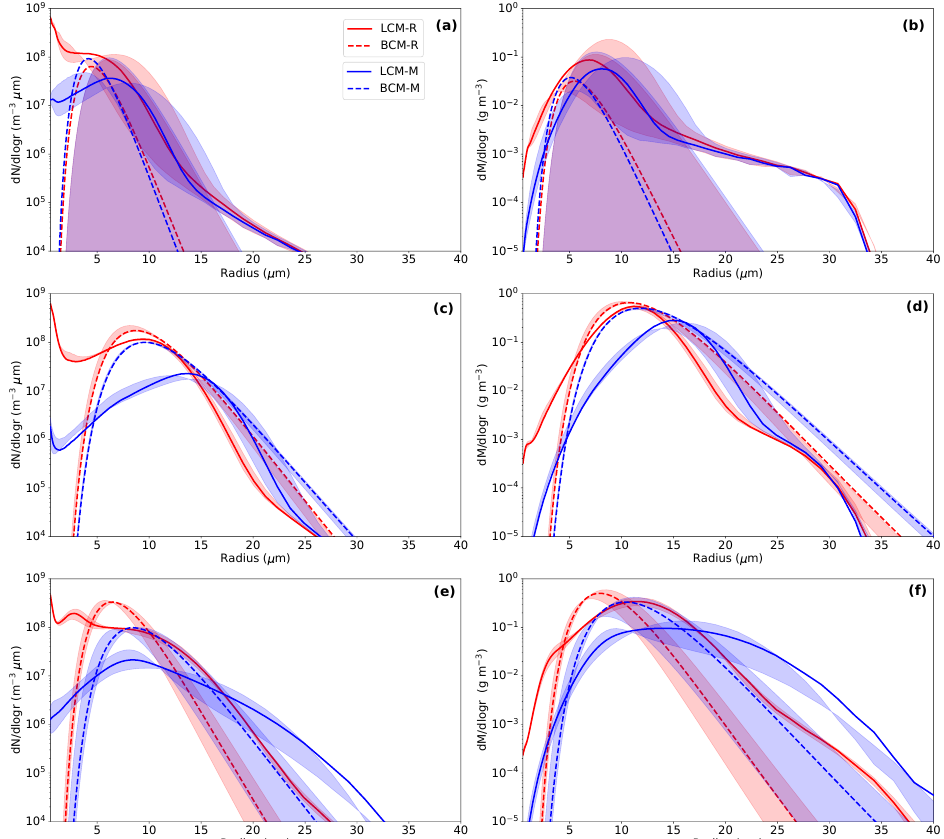
Figure 4. Instantaneous drop size distributions of number and mass density at 0300UTC ( a , b ), 0600UTC ( c , d ) and 0800UTC ( e , f ) averaged over the fog layer of the simulations listed in Table 2. The shaded area indicates the shift of the spectrum in an interval of 1 h around the discrete